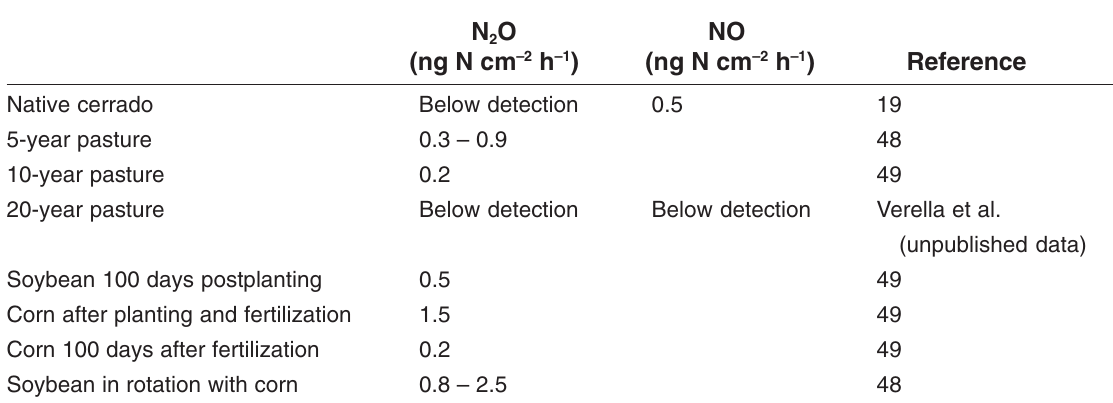
Effects of Land Use Change in the Cerrado Region of Brazil